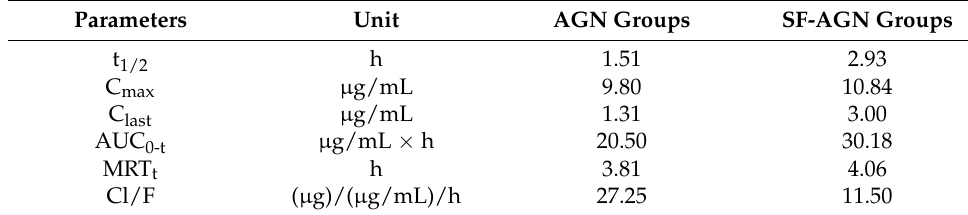
Table 2. Pharmacokinetic parameters of AGN and SF-AGN.